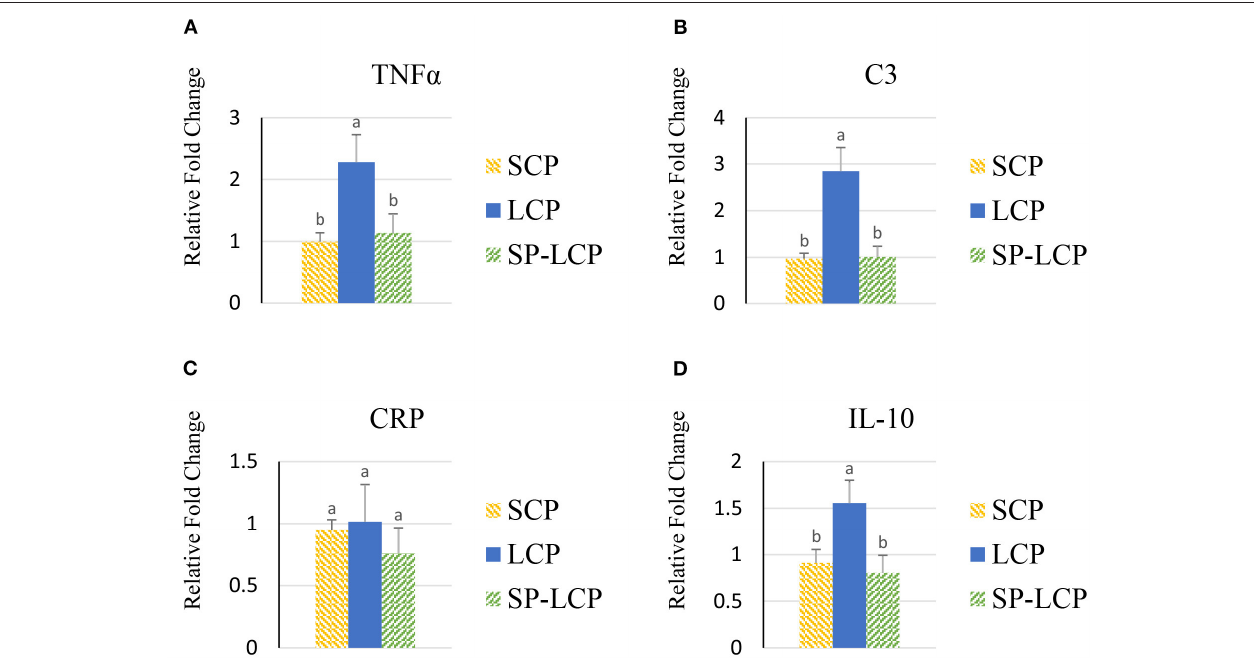
FIGURE 2 | Effects of Spirulina on circulating TNF α , C3, CRP, and IL-10 expression. Relative mRNA abundance of circulating TNF- α (A) , C3 (B) , CRP (C) , and IL-10 (D) expression in broilers on day (d) 37 were determined by real-time qPCR. Treatments include standard corn/soy (SCP) diet as control and low crude protein without (LCP) or with Spirulina (SP-LCP). Data are presented as mean ± SEM ( n = 8/group). Means with different letters are significantly different ( P < 0.05).